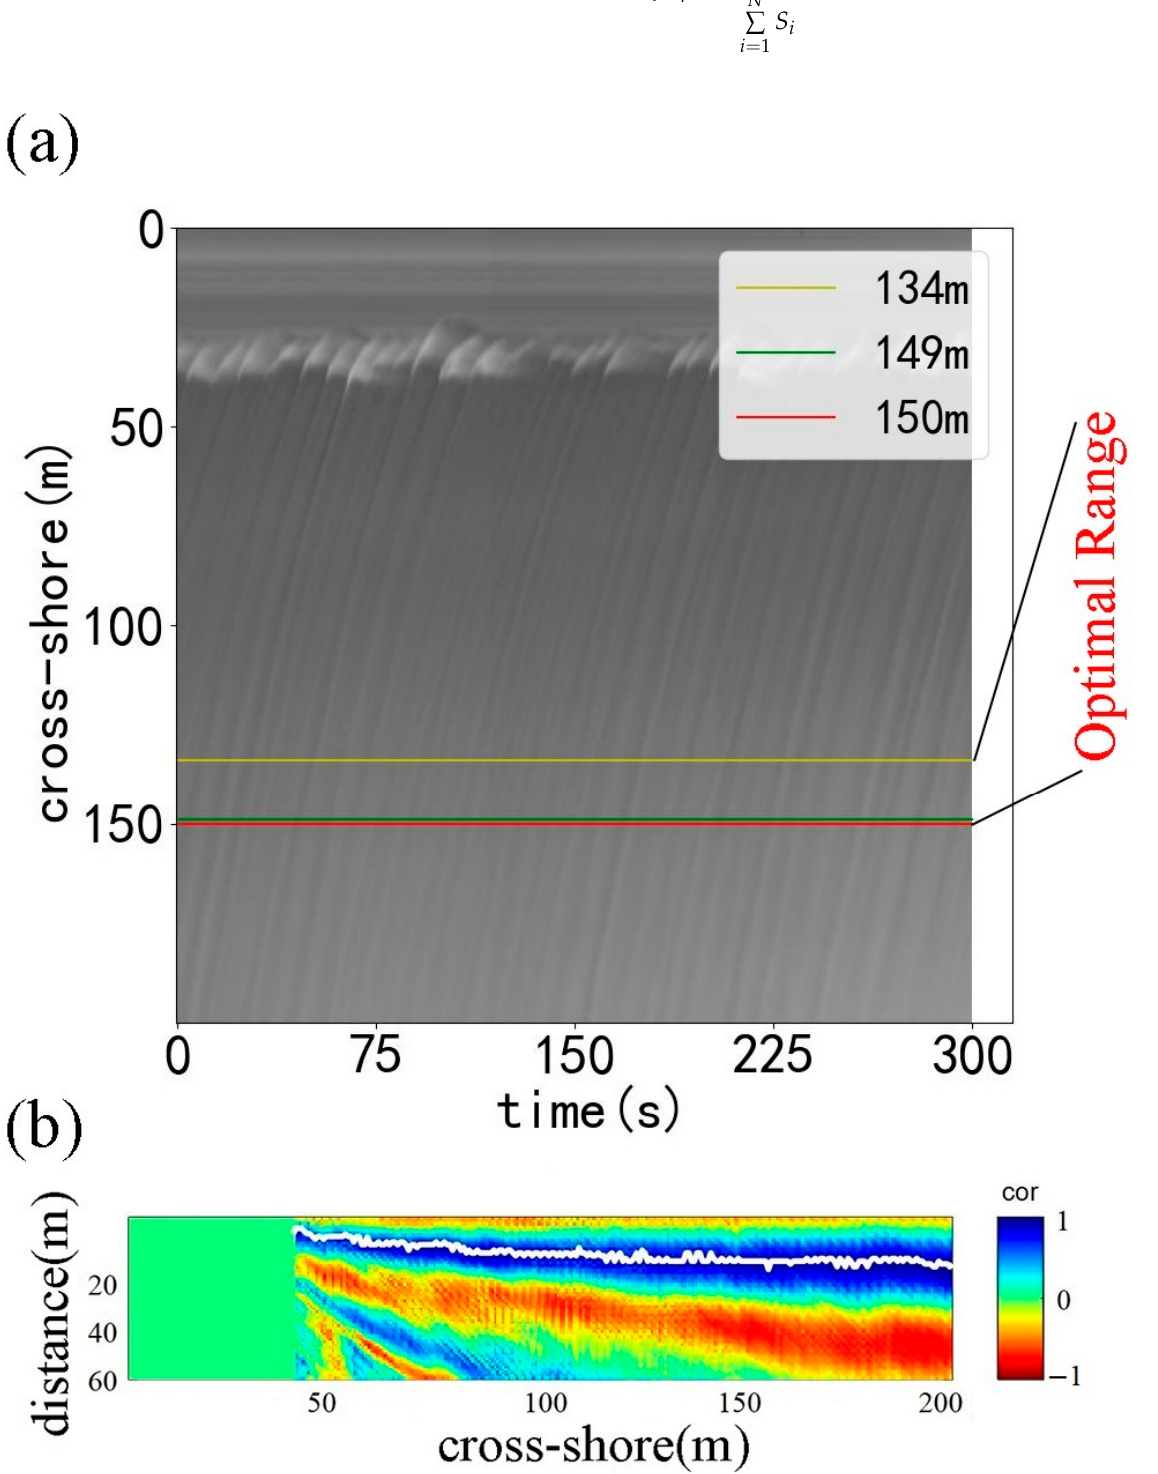
Figure 12. Optimal range estimation. ( a ) The cross-correlation calculation is carried out with this reference point (the red line) towards the shore. An optimal range is determined. ( b ) The relationship between pixel intensity cross-correlation and distance in the whole region.